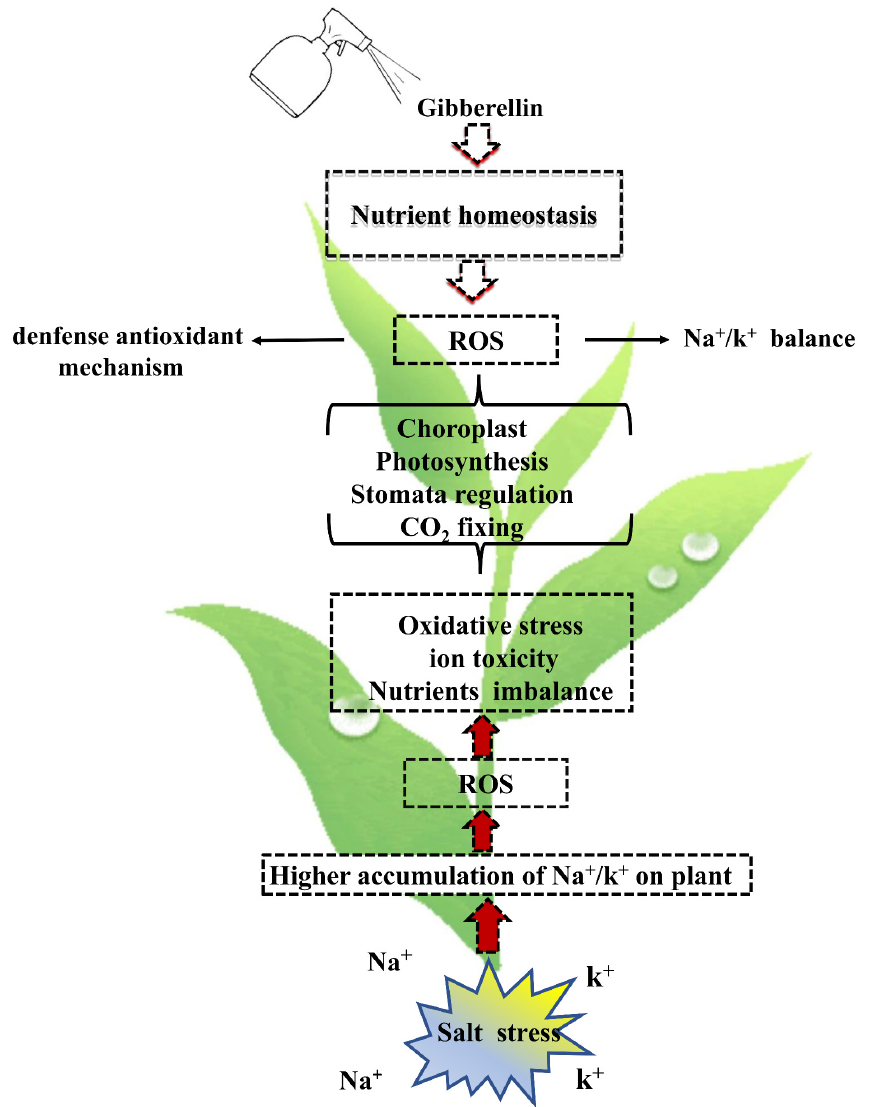
Figure 2. Functions of GAs in the regulation of photosynthesis under salt stress. In the absence of GA, salt stress results in an imbalance of Na + /K + homeostasis, which leads to the production of ROS. This salinity-induced ROS production, in turn, exerts oxidative stress on plants, resulting in stomatal closure and reduced activity of CO 2 -fixing enzymes, resulting in a decrease in photosynthesis. In the presence of GA, Na + /K + homeostasis, and nutrient homeostasis are maintained, and the antioxidant defense mechanism is activated, which limits ROS production, thereby preventing ROS-induced oxidative stress. In the absence of oxidative stress, the rate of photosynthesis is maintained during salt